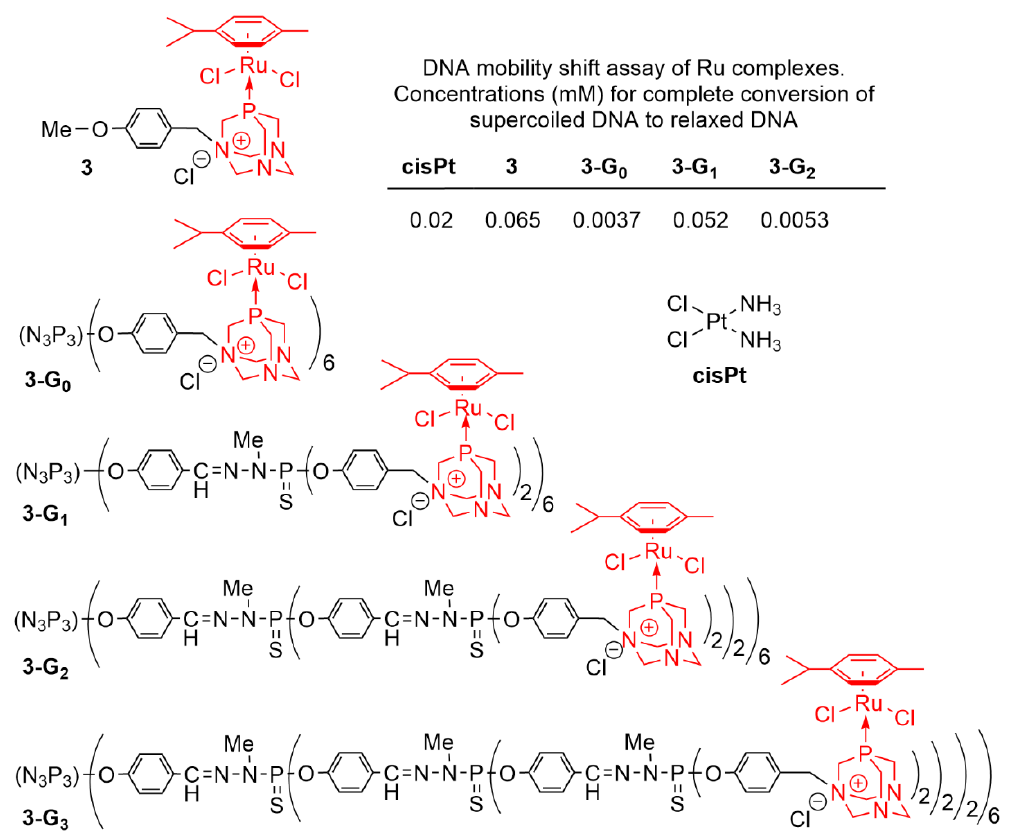
Figure 4. Dendrimers 3-Gn functionalized by PTA-Ru complexes and their efficiency to convert the supercoiled form of DNA to the relaxed form, compared to cisplatin.